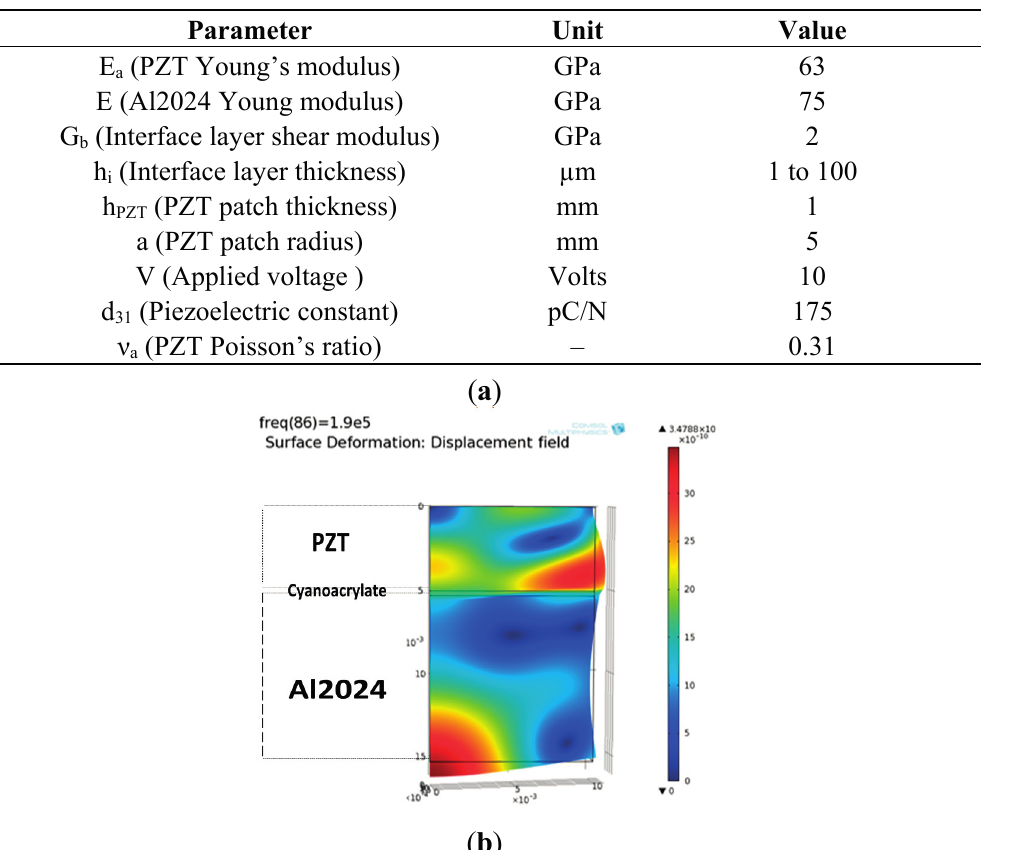
Figure 6. ( a ) Simulation parameters; ( b ) FEM simulation of the global displacement field that PZT patch produces on the host structure. The simulation was performed using parameters and for an epoxy bonding of 1 µm